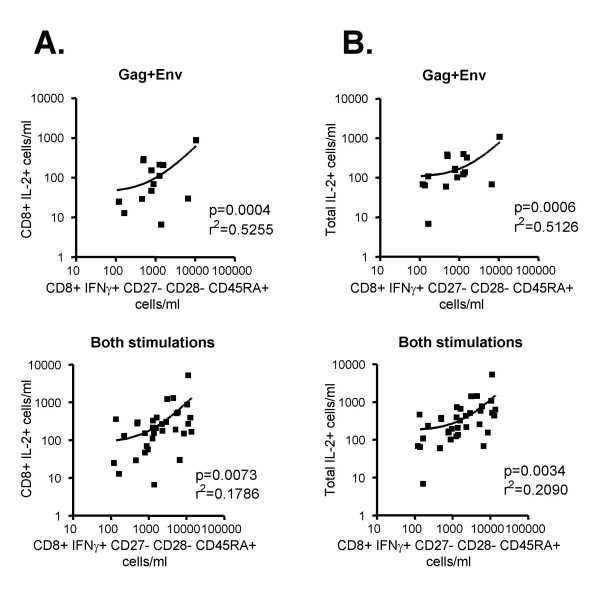
Correlation analyses of IL-2 production and effector cell differentiation. A. Top, the absolute number of the HIV-specific CD8+ IFNγ+ IL-2+ T cells is plotted against the absolute number of the HIV-specific CD8+ terminal effector T cells (CD27- CD28- CD45RA+); bottom, the same correlation, but including CMV-specific responses of the same subjects. B. Top, the absolute number of all HIV-specific IFNγ+ IL-2+ cells (both CD8+ and CD4+) is plotted against all HIV-specific terminal effector T cells; bottom, the same correlation, but including CMV-specific responses of the same subjects. In all correlations, each square represents a single subject's CMV or HIV response.